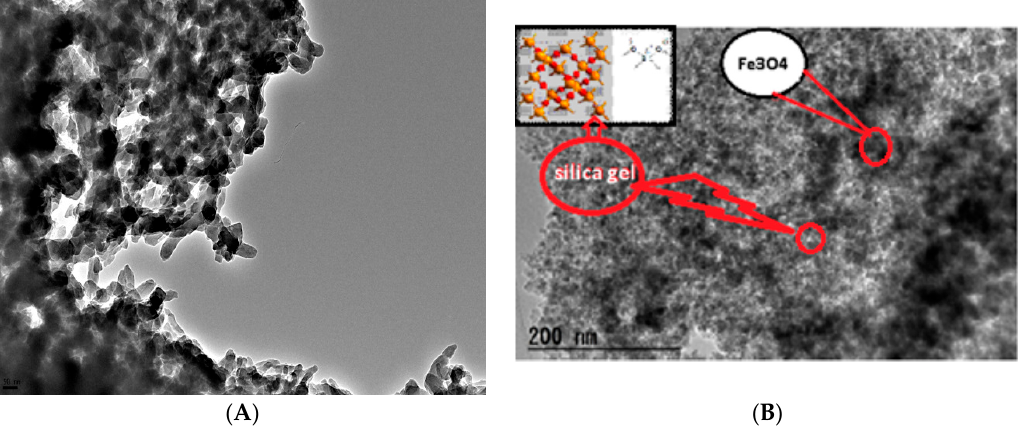
Figure 6. TEM imaging of ( A ) amine-functionalized silica gel (ANSG) and ( B ) magnetic amine-functionalized silica gel (MANSG).